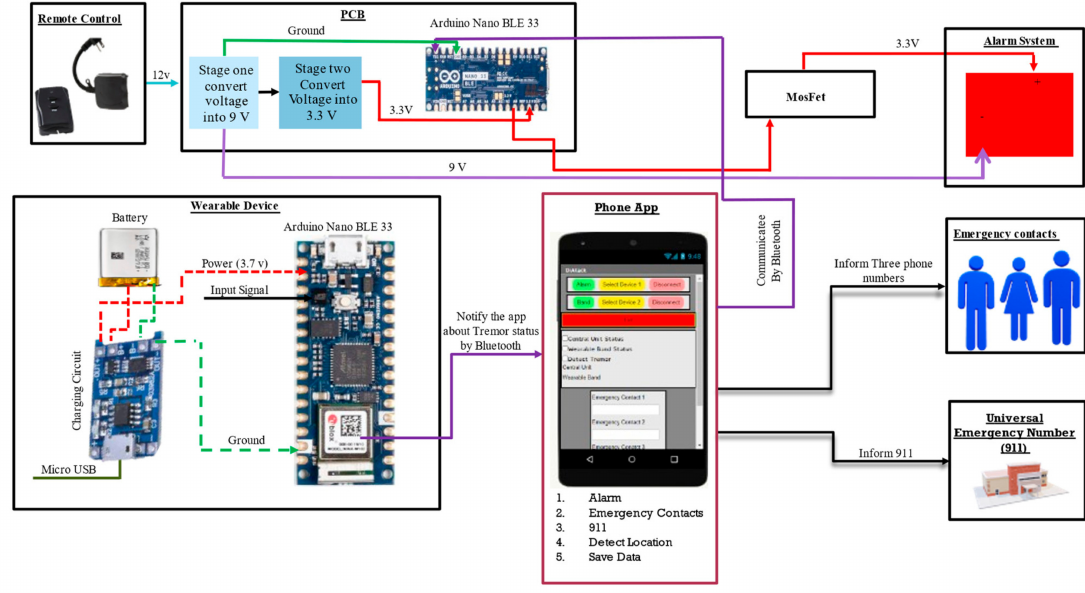
Figure 2. DiAtack functional block